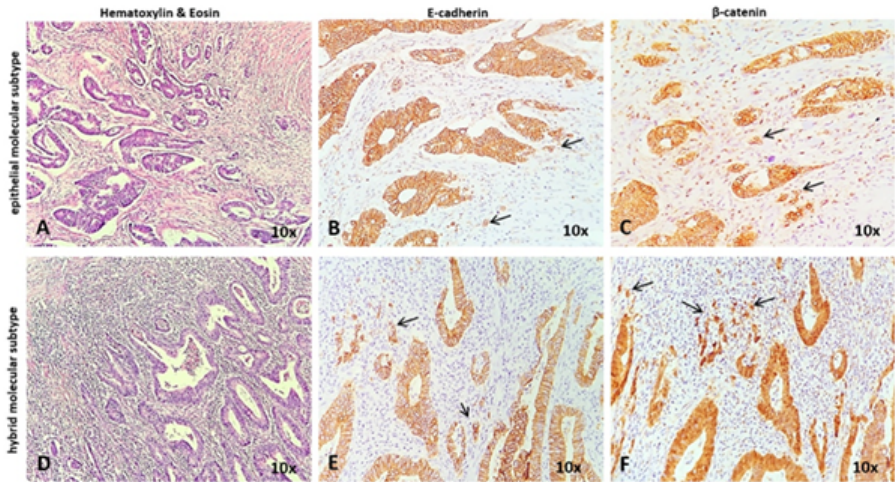
Figure 7. Histological aspect, correlated with the molecular subtype determined with E-cadherin and β -catenin. All tumors expressed membranar E-cadherin and β -catenin in the tumor core ( A – F ). In the epithelial subtype, the membrane expression of E-cadherin ( B ) and beta-catenin ( C ) can be seen in both tumor core and invasion area (buds). The hybrid molecular subtype is characterized by membranar expression of E-cadherin and beta-catenin in the tumor core ( E , F ) with nuclear positivity of β -catenin in the buds ( F ).